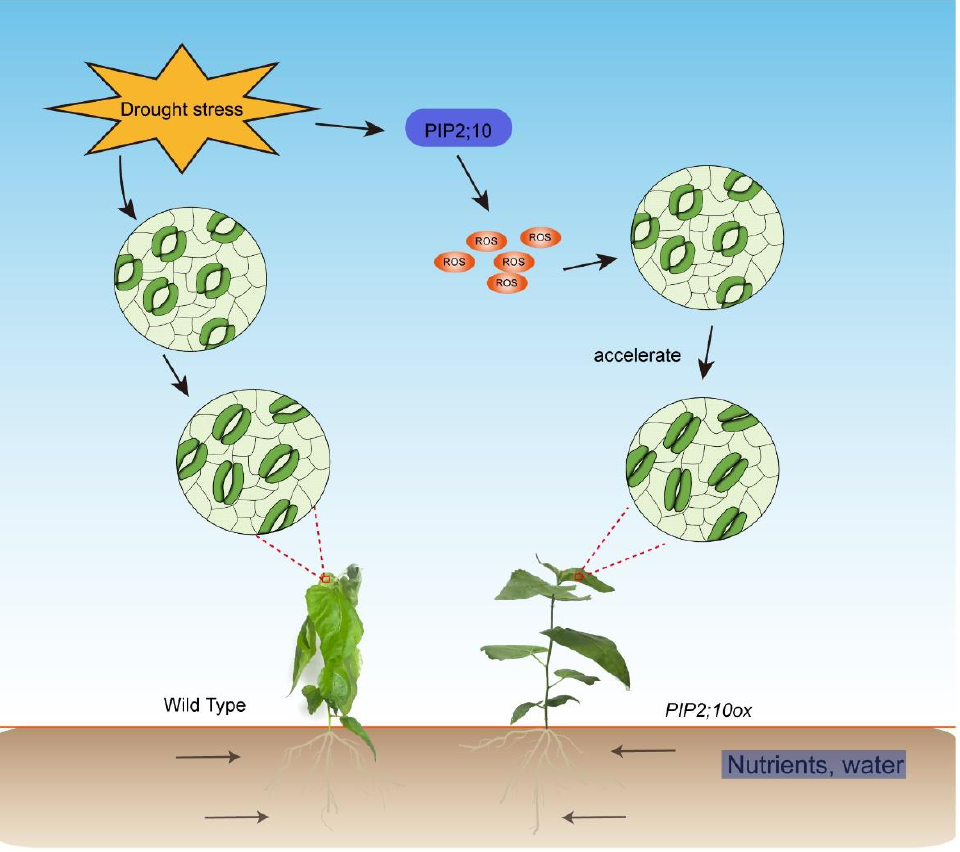
Figure 7. A possible working model for PagPIP2;10 improves drought tolerance. PIP2;10 transcription is induced by drought, which promotes ROS accumulation in guard cells and accelerates stomatal closure rate; the L pr of overexpression lines was higher than WT.